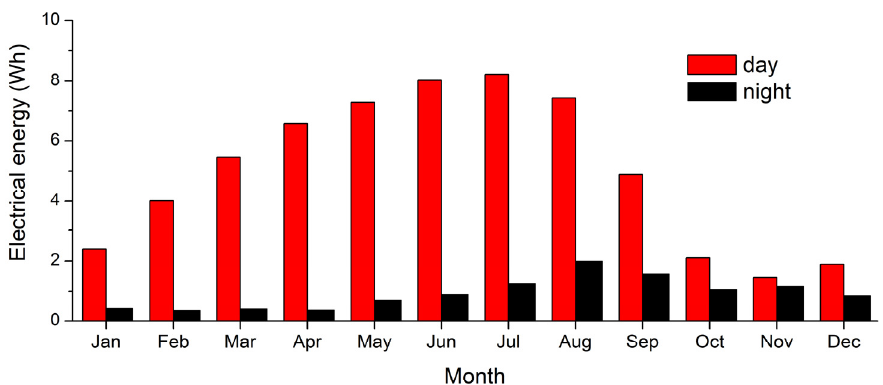
Figure 12. STEG monthly electrical energy estimated from model (year 2016). Data available in the Supplementary Materials.